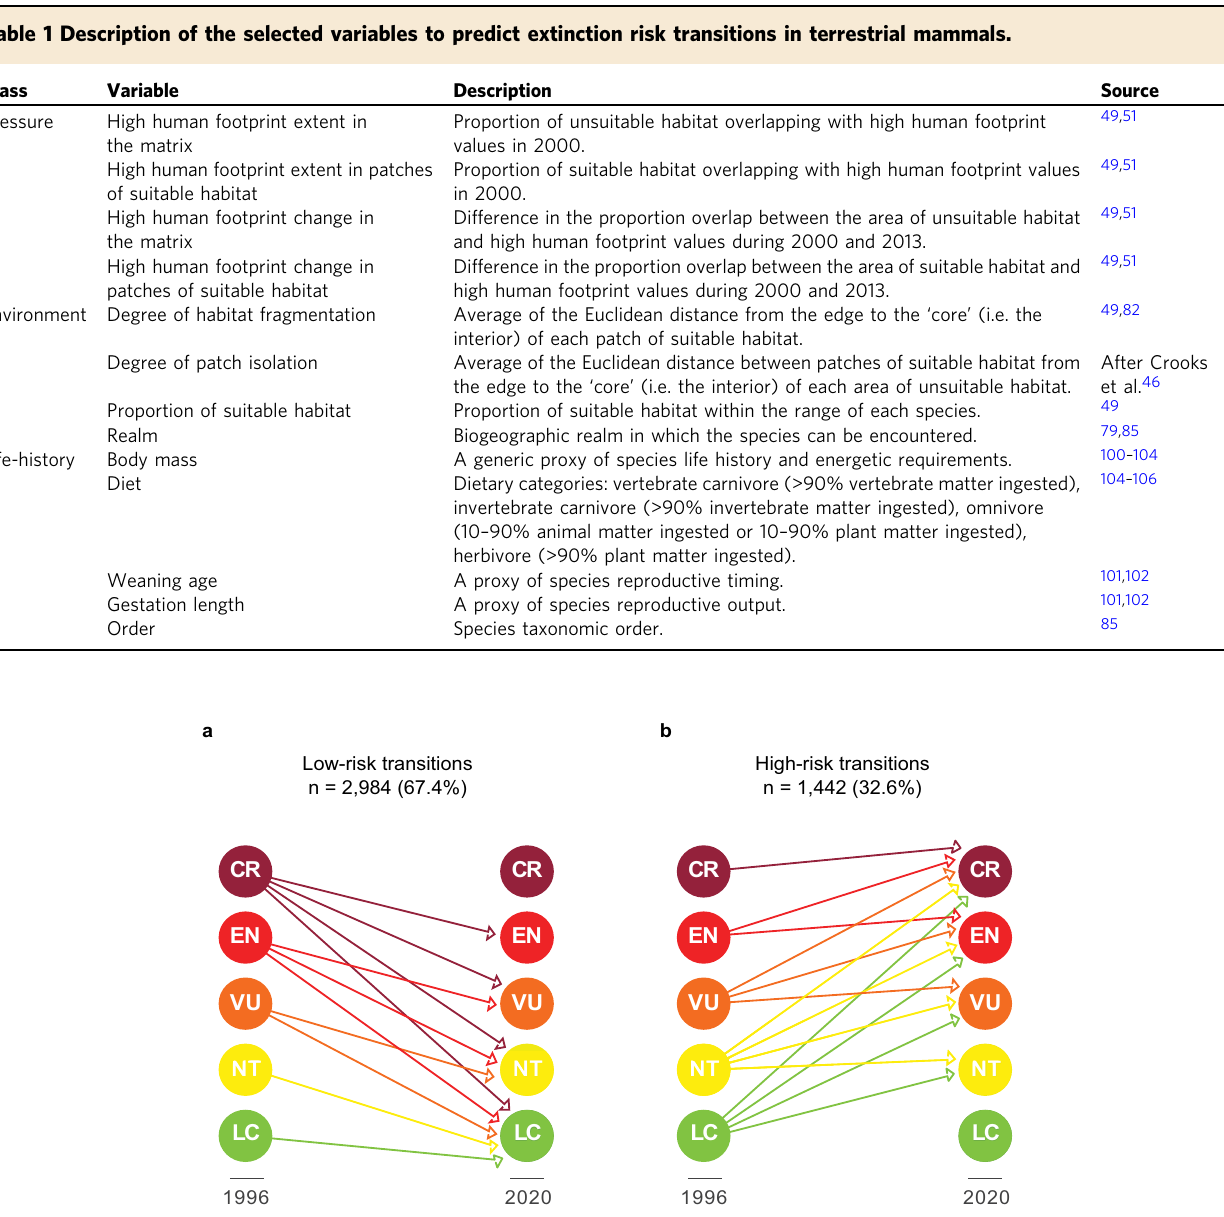
Fig. 1 Classi fi cation of species extinction risk transitions based on past and present IUCN Red List categories * . a Low-risk transitions included species that retained a category of least concern, together with those species that moved from any higher category of threat to a lower category between 1996 and 2020. b High-risk transitions included all species that retained a category of threatened or near threatened, together with those species that moved from any lower category of threat to a higher category between 1996 and 2020. * Acronyms refer to the IUCN Red List categories, including Least Concern (LC), Near Threatened (NT), Vulnerable (VU), Endangered (EN), and Critically Endangered (CR).